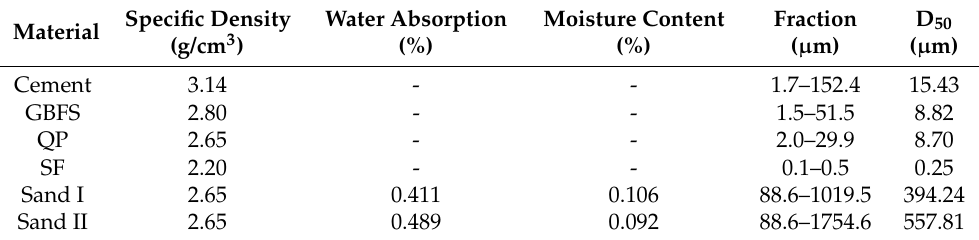
Figure 1. Particle size distribution of materials used. Table 2. Physical properties and particle size statistics of the materials used.